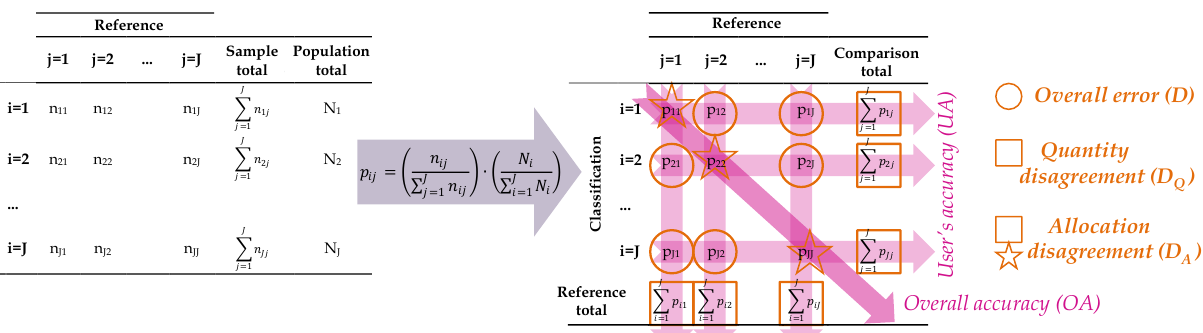
Figure 6. Traditional error matrix vs. estimated population matrix. Notation: the number of categories is J and each category in the classification is denoted by an index i and the reference sample is denoted by an index j , which ranges from 1 to J . The number of elements in each category is N i . The number of extracted objects assigned to category i and its category j in the reference sample is denoted by n ij . The estimated proportion of the study area that is category i in the extracted object and category j in the reference sample is denoted by p ij . The elements used to calculate the agreement metrics are shown in magenta and the elements used to calculate the disagreement metrics are shown in